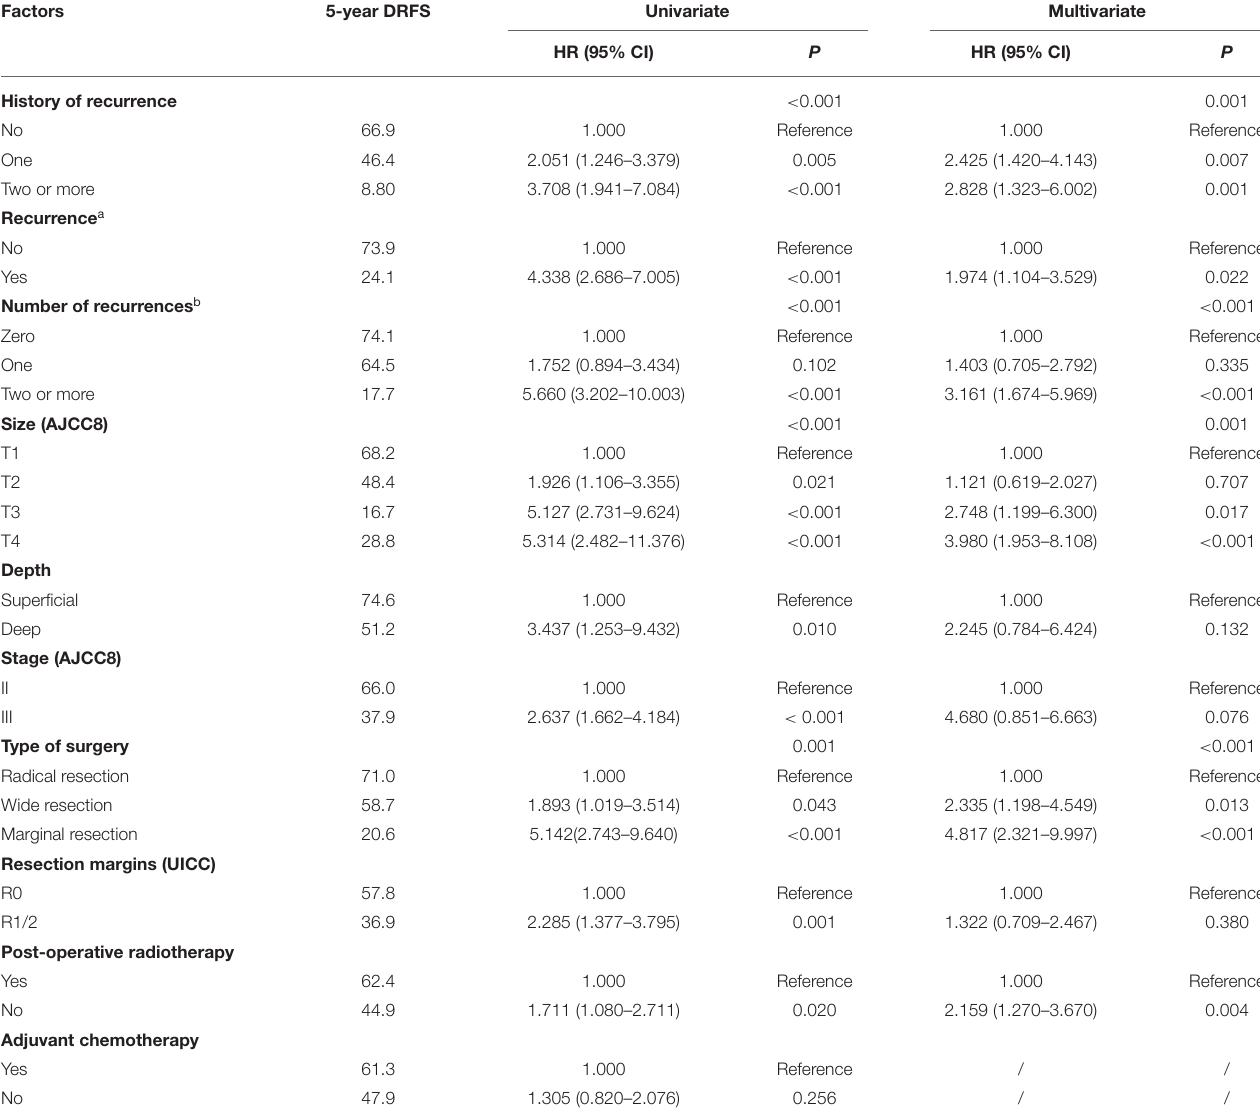
TABLE 3 | Univariate and multivariate analysis of variable factors and DRFS. Factors 5-year DRFS Univariate Multivariate